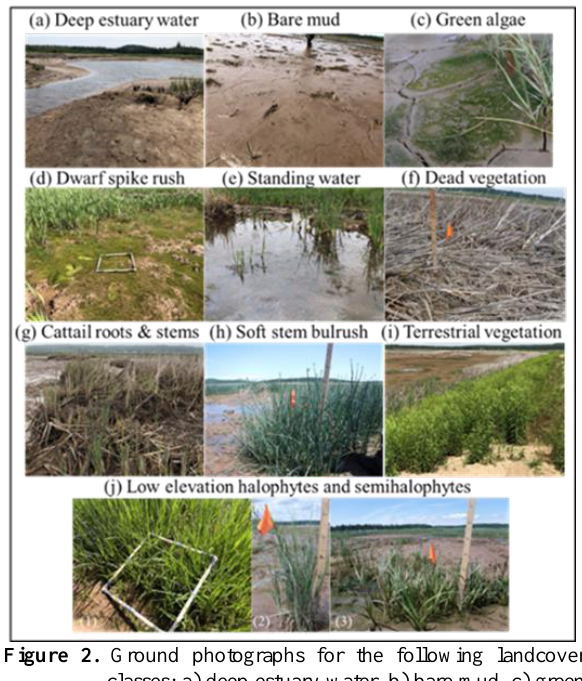
Figure 2. Ground photographs for the following landcover classes: a) deep estuary water, b) bare mud, c) green macroalgae (Chlorophyta), d) dwarf spike rush ( Eleocharis parvula ), e) cloudy standing water, f) dead vegetation, g) cattail ( Typha spp.) roots and stems, h) soft stem bulrush ( Schoenoplectus tabernaemontani ), i) terrestrial vegetation (light), and j) low elevation halophytes and semi-halophytes (1: Bolboschoenus maritimus , 2: Spartina pectinata , 3: Spartina alterniflora